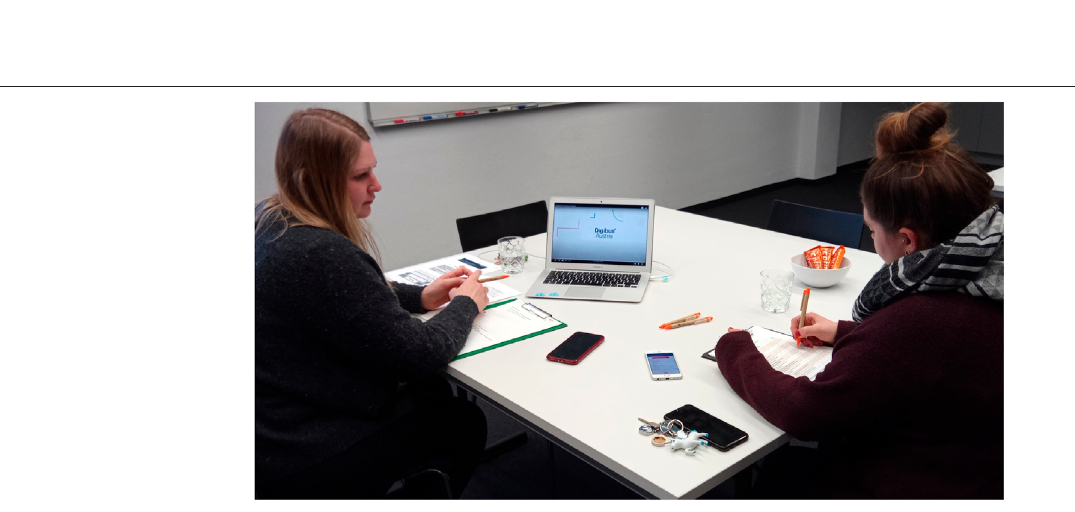
Frontiers in Human Dynamics |